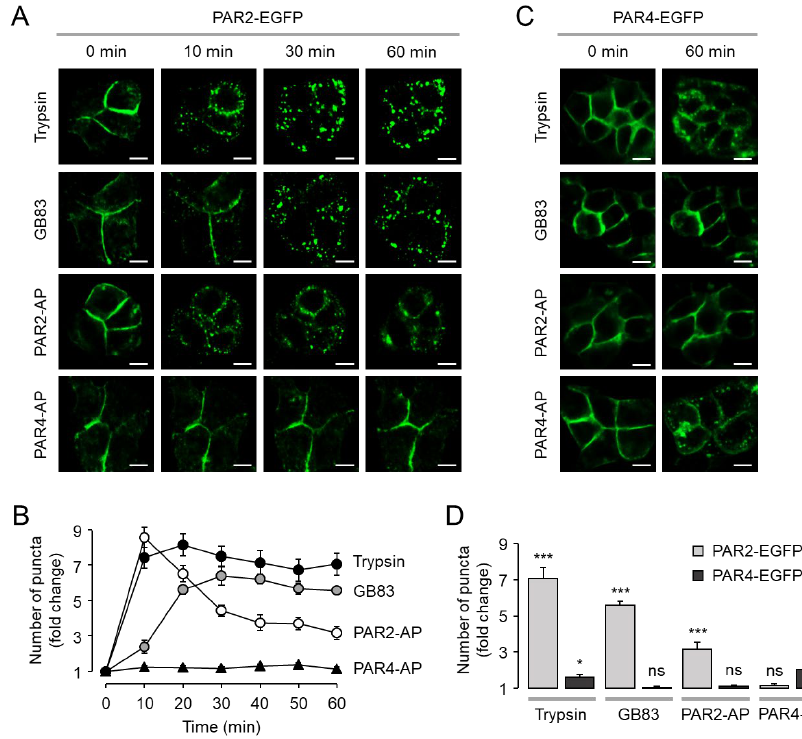
Figure 5. GB83 selectively and strongly internalized PAR2 in HT-29 cells. ( A ) EGFP-tagged PAR2 expressing HT-29 cells were treated with trypsin (30 U/mL), GB83 (30 µM), PAR2-AP (30 µM), and PAR4-AP (100 µM). Changes in cellular localization of EGFP-tagged PAR2 were observed at the indicated time points. ( B ) Quantitative analysis of the effect of trypsin, GB83, PAR2-AP, and PAR4-AP on PAR2 internalization. Summary of fold change in the number of puncta (mean ± S.E., n = 5). ( C ) EGFP-tagged PAR4 expressing HT-29 cells were treated with trypsin (30 U/mL), GB83 (30 µM), PAR2-AP (30 µM), and PAR4-AP (100 µM). Changes in cellular localization of EGFP-tagged PAR4 were observed at the indicated time points. ( D ) Quantitative analysis of the effect of trypsin, GB83, PAR2-AP, and PAR4-AP on PAR2 and PAR4 internalization. Summary of fold change in the number of puncta at 60 min (mean ± S.E., n = 5). Statistical significance of differences between indicated group with that before treatment was assessed by one-way ANOVA with Tukey’s post-hoc test. * p < 0.05, ** p < 0.01, *** p < 0.001, ns, not